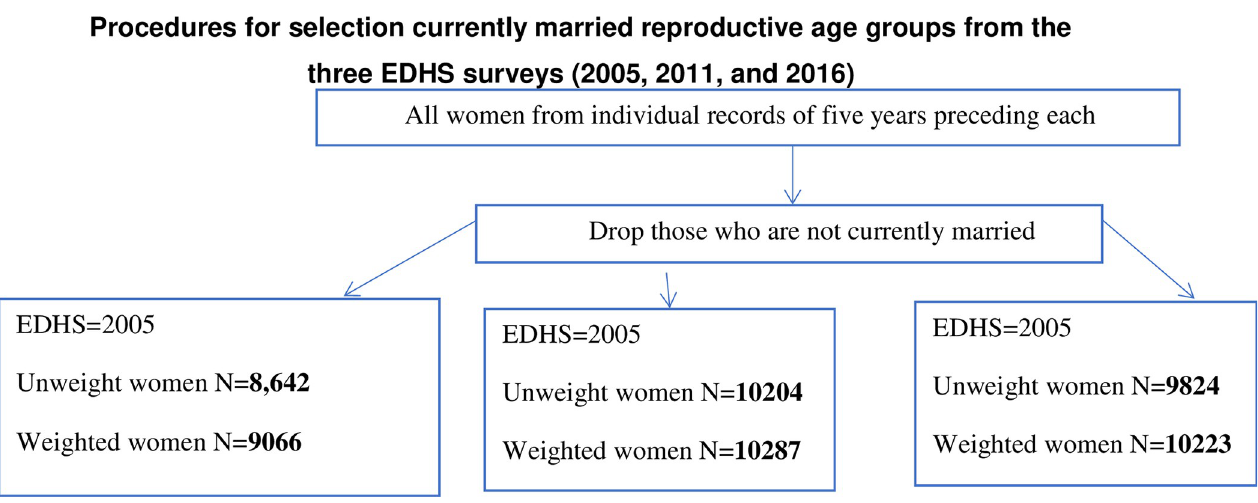
Fig 1. Sample size for unmet need for family planning in Ethiopia based on the EDHS 2005, 2011, and 2016.